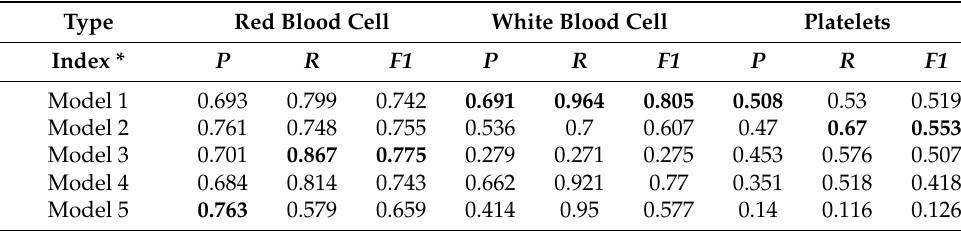
Table 5. Results of the validation data of all models when confidence score is